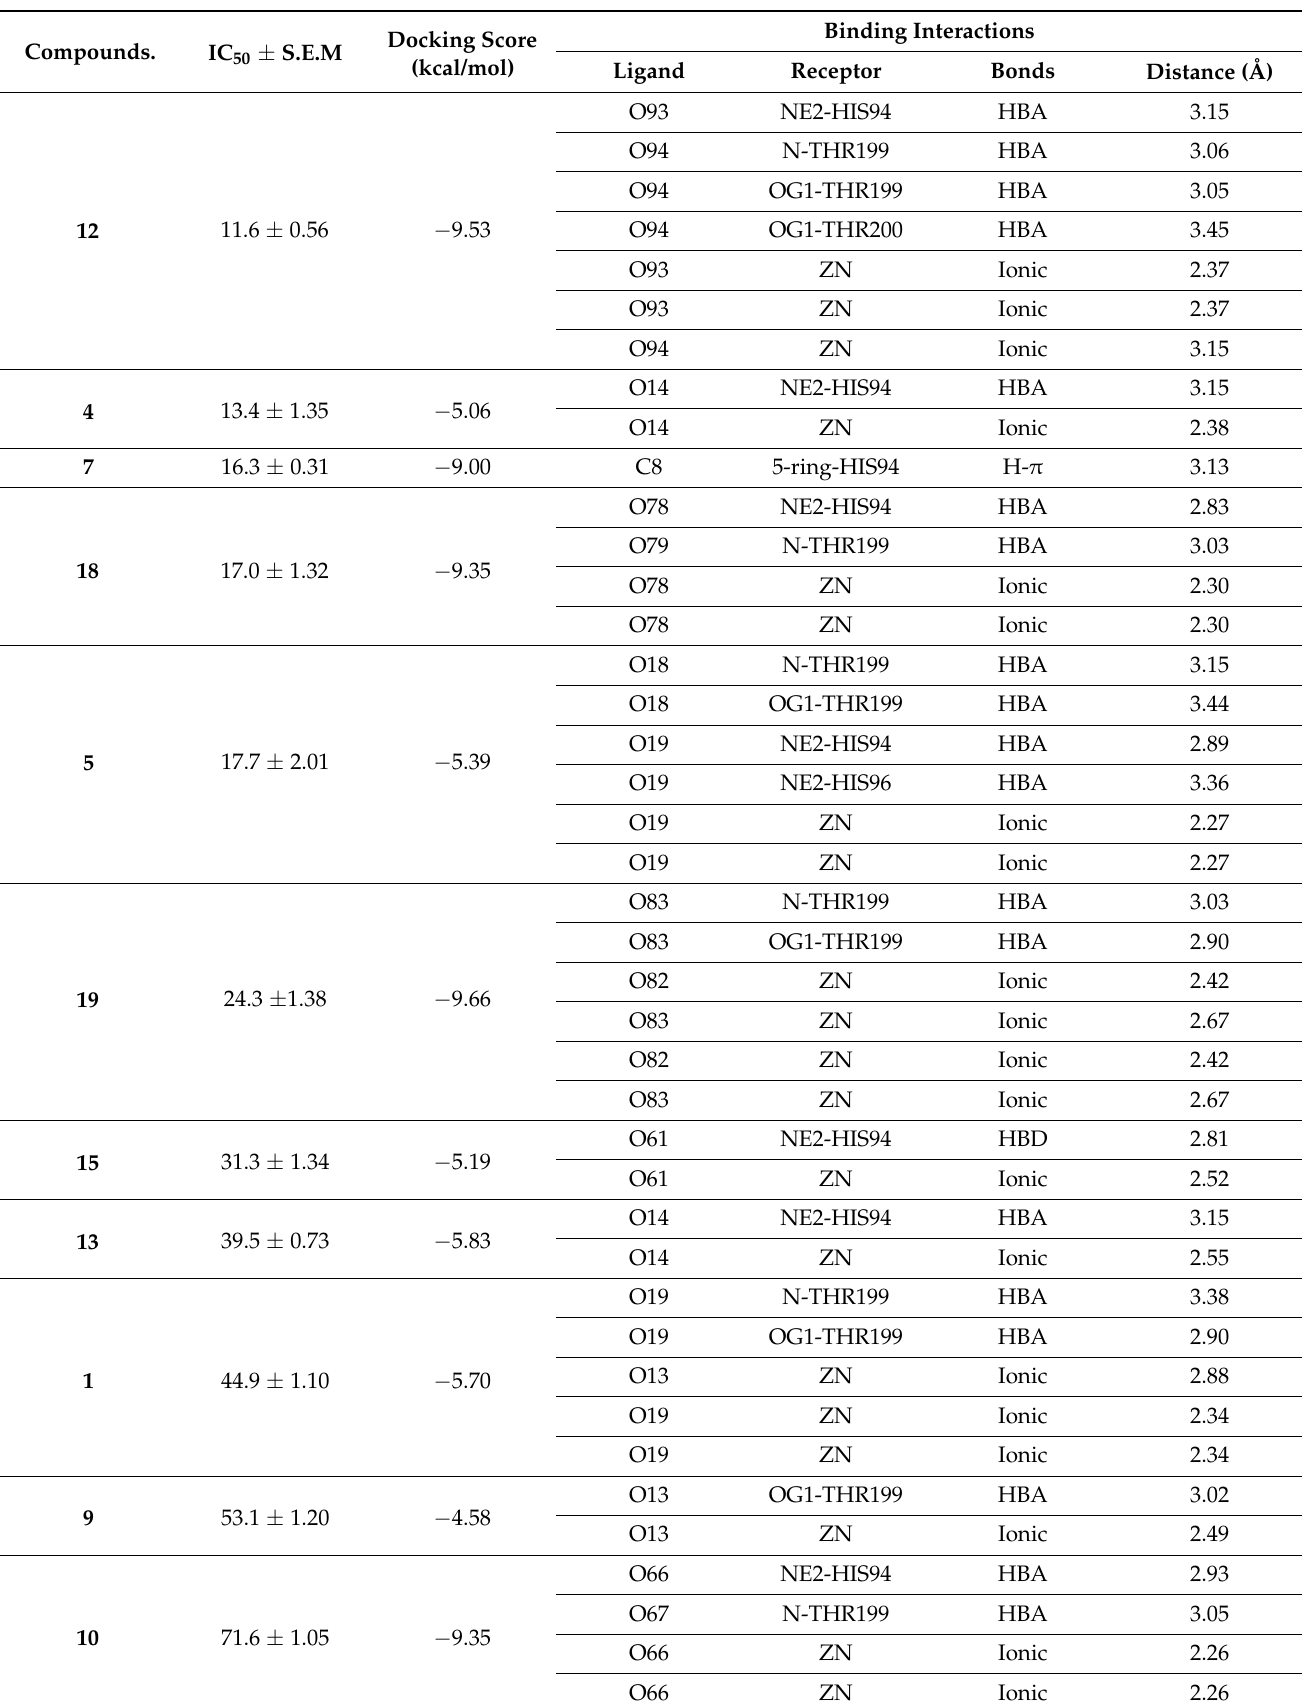
Table 2. The docking scores and binding interactions of compounds 1 , 4 , 5 , 7 , 9–10 , 12–13 , 15 , 18–19 , and acetazolamide.